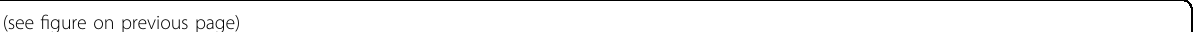
Fig. 4 hUC-MSCs suppress the activation and pro-in fl ammatory cytokine secretion of hepatic T cells through CHI3L1 in Con A-induced hepatitis. A Representative plots and quanti fi cation ( B ) of fl ow cytometry analysis for CD3 + T cells in liver MNCs 24h after Con A administration in indicated groups. C – F Representative plots and quanti fi cation of fl ow cytometry analysis for CD25 ( C – D ) and CD69 ( E – F ) expression in CD3 + T cells in liver MNCs 24h after Con A administration in indicated groups. G – J Representative plots and quanti fi cation of fl ow cytometry analysis for IFN- γ ( G – H ) and TNF- α ( I – J ) -producing CD3 + T cells in liver MNCs 24h after Con A administration in indicated groups. K Serum concentrations of IL6, IFN- γ , and TNF- α 24h after Con A administration in indicated groups were detected by CBA kit. Analyses in ( G – J ) were conducted with liver MNCs stimulated with PMA (50ng/mL), ionomycin (500 ng/mL) and BFA (10 μ g/mL) for 6 h after isolation. Data in ( B ), ( D ), ( F ), ( H ), ( J ), and ( K ) are shown as mean± SD ( n = 5 for each group) with indicated signi fi cance (* p < 0.05, ** p <